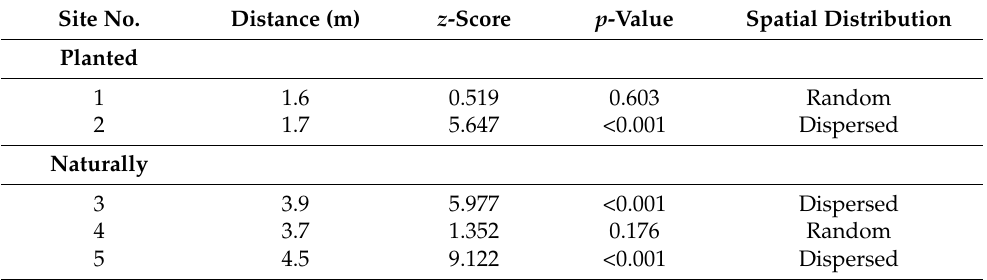
Table 4. Mean distance between trees within each stand and statistics of the average nearest neighbor statistic method characterizing the spatial distribution pattern within each tested stand. Site No. Distance (m) z -Score p -Value Spatial Distribution